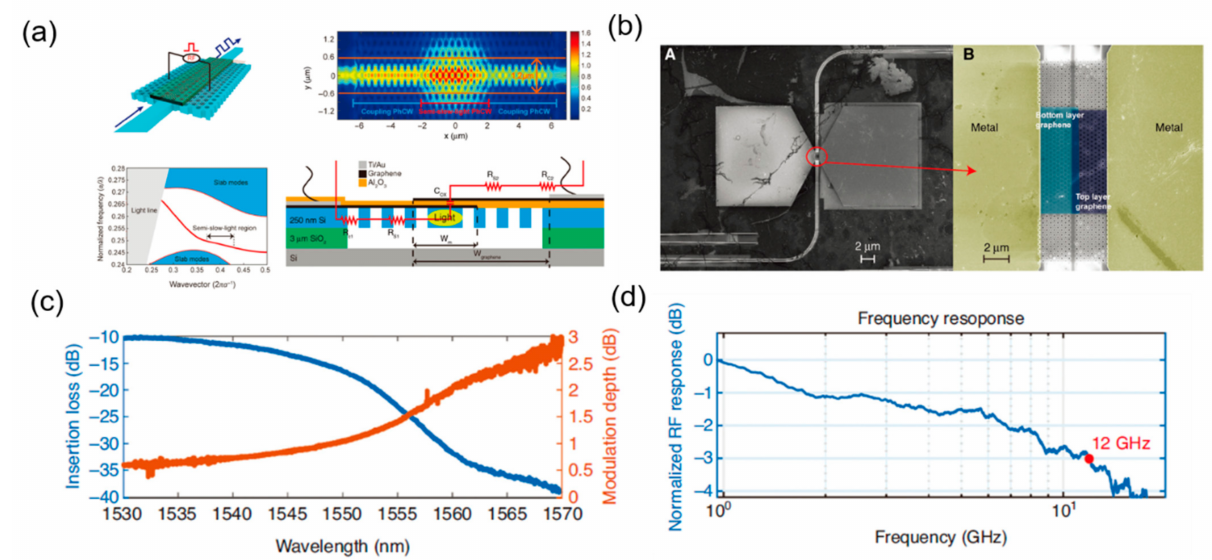
Figure 11. Silicon-based graphene photonic crystal modulator. ( a ) Structure, photonic band diagram, electric field distribution, and equivalent circuit of the graphene modulator [62]. ( b ) SEM image of the fabricated double-layer graphene modulator [62]. ( c ) Insertion loss and modulation depth with the change of wavelength [62]. ( d ) Frequency response of the silicon-based graphene photonic crystal modulator